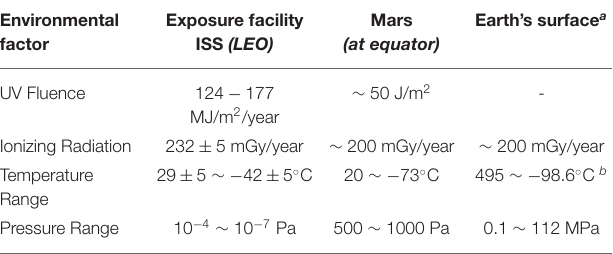
TABLE 1 | Measured values for the different environmental factors studied on the Exposure Facility aboard the ISS (Kawaguchi et al., 2020), the equator of Mars (Kminek and Bada, 2006; Cortesão et al., 2021), and Earth’s surface (Shahbazi-Gahrouei et al., 2013; Merino et al.,